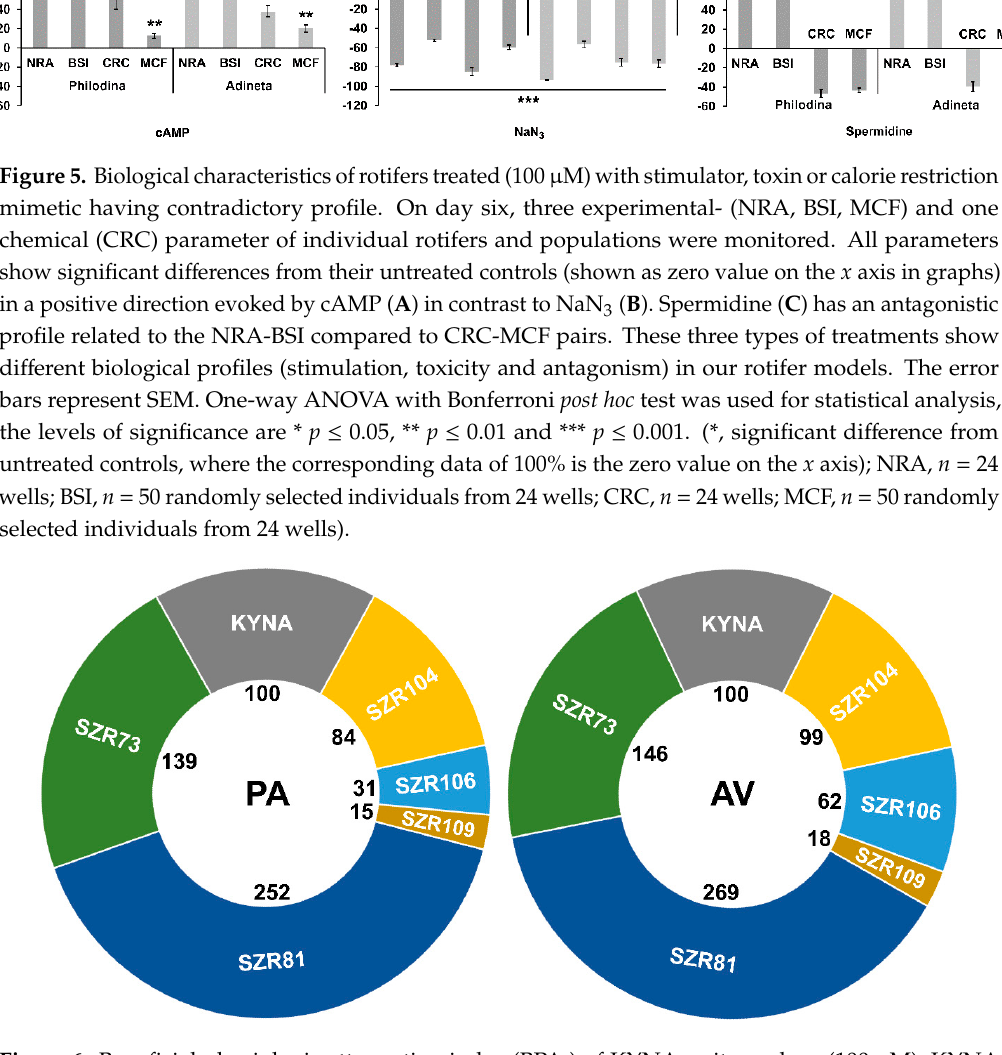
Figure 6. Beneficial physiologic attenuation index (BPA i ) of KYNA or its analogs (100 µ M). KYNA is the reference molecule (100% BPA) for SZR analogs. SZR73 and SZR81 were the best compounds based on their physiological influences on Philodina acuticornis (PA) and Adineta vaga (AV) species. All monitored rotifer-specific parameters were integrated into a comprehensive mathematical formula, calculating percentile beneficial physiologic attenuation (BPA) data.